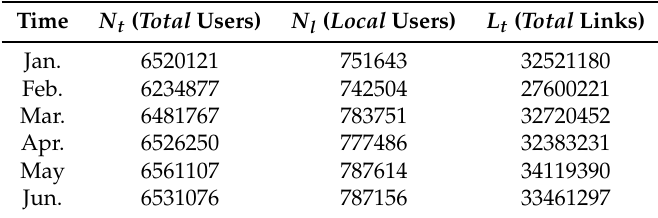
Table 1. Basic statistics of the mobile communication